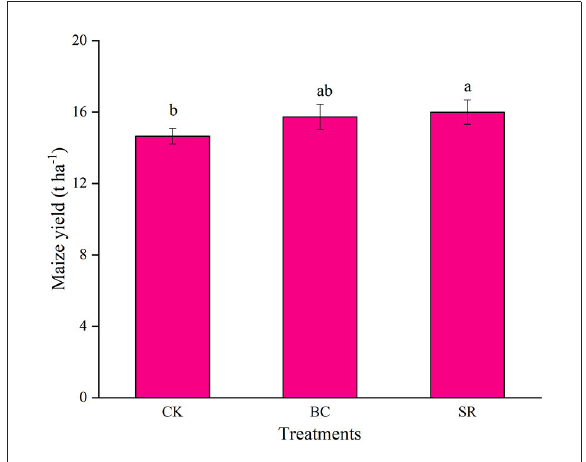
FIGURE4 Effect of maize straw and straw-derived biochar on maize yield. The error bars represent the standard deviations of the mean values ( n = 3). Different lowercase letters indicate significant differences between the different